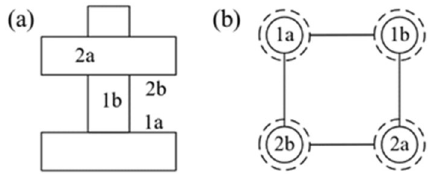
Figure 4. Toy example of feature graph in one